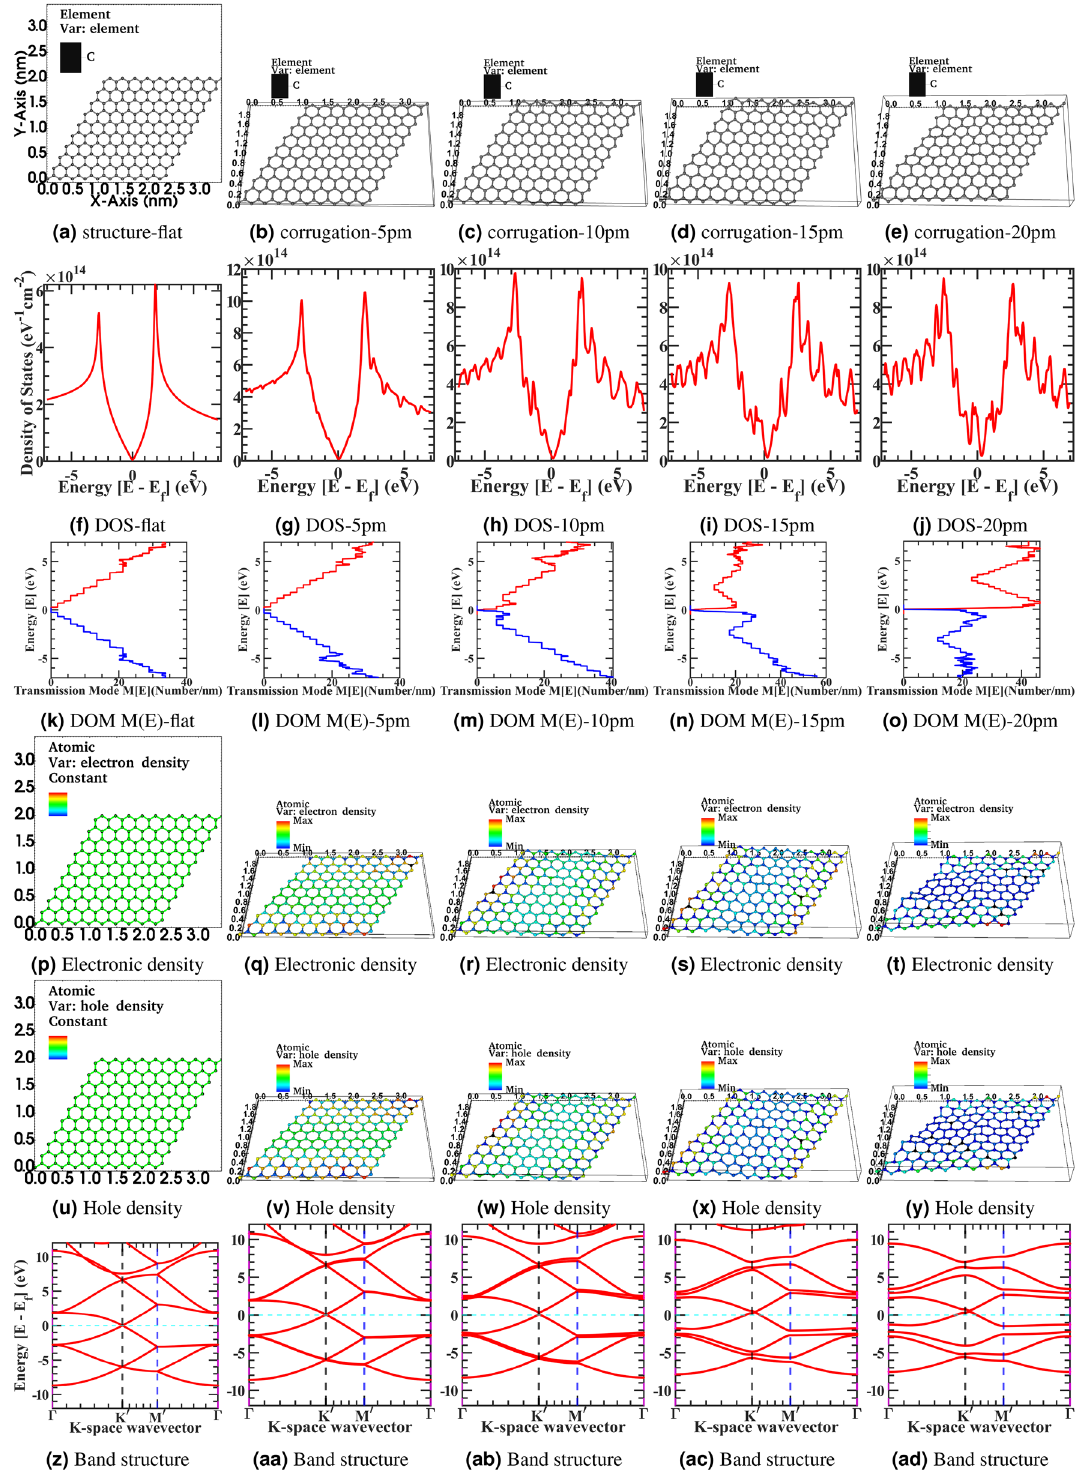
Figure 1. Device structure 10x10 graphene supercell ( a – e ) corrugate-5pm to −20pm, Density of state ( f ) flat to ( j ) corrugate-5pm to −20pm, Electronic density of modes M(E) in x-y Direction ( k ) flat to ( o ) corrugate-5pm to -20pm, Electronic density ( p ) flat to ( t ) corrugate-5pm to −20pm, Hole density ( u ) flat to ( y ) corrugate-5pm to −20pm, and Electronic band structure ( z ) flat to ( ad ) corrugate-5pm to